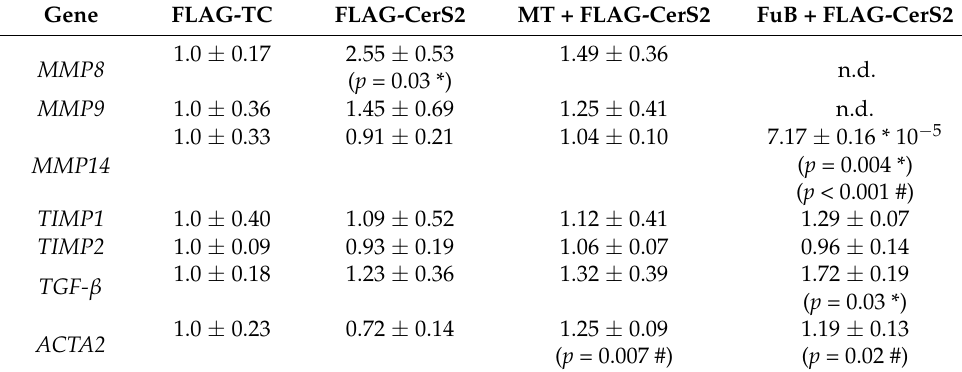
Table 9. Fibrosis related mRNA expression in transfected